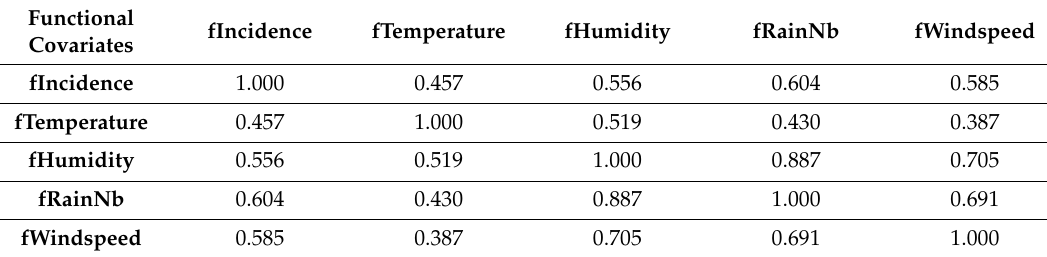
Table 2. Distance correlation among functional covariates e